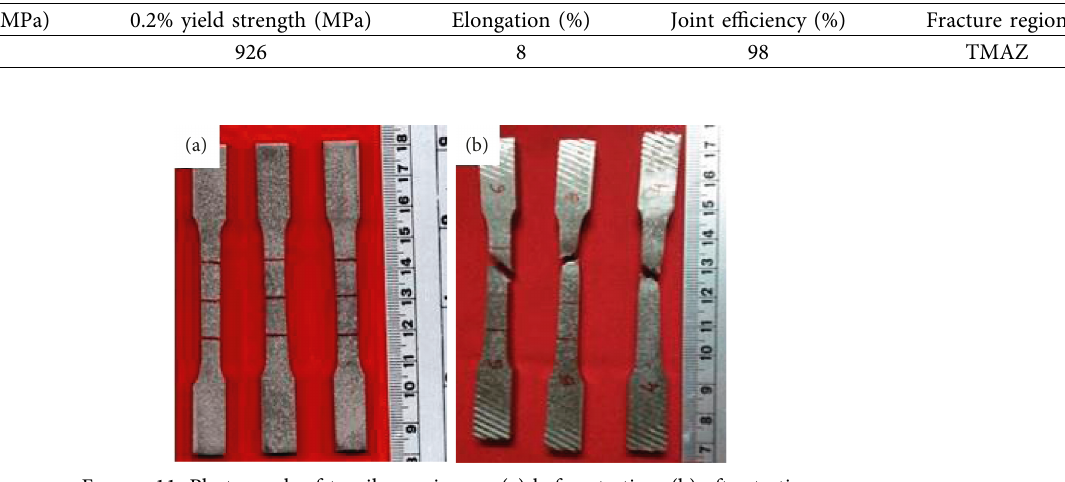
Figure 11: Photograph of tensile specimens: (a) before testing; (b) after testing.